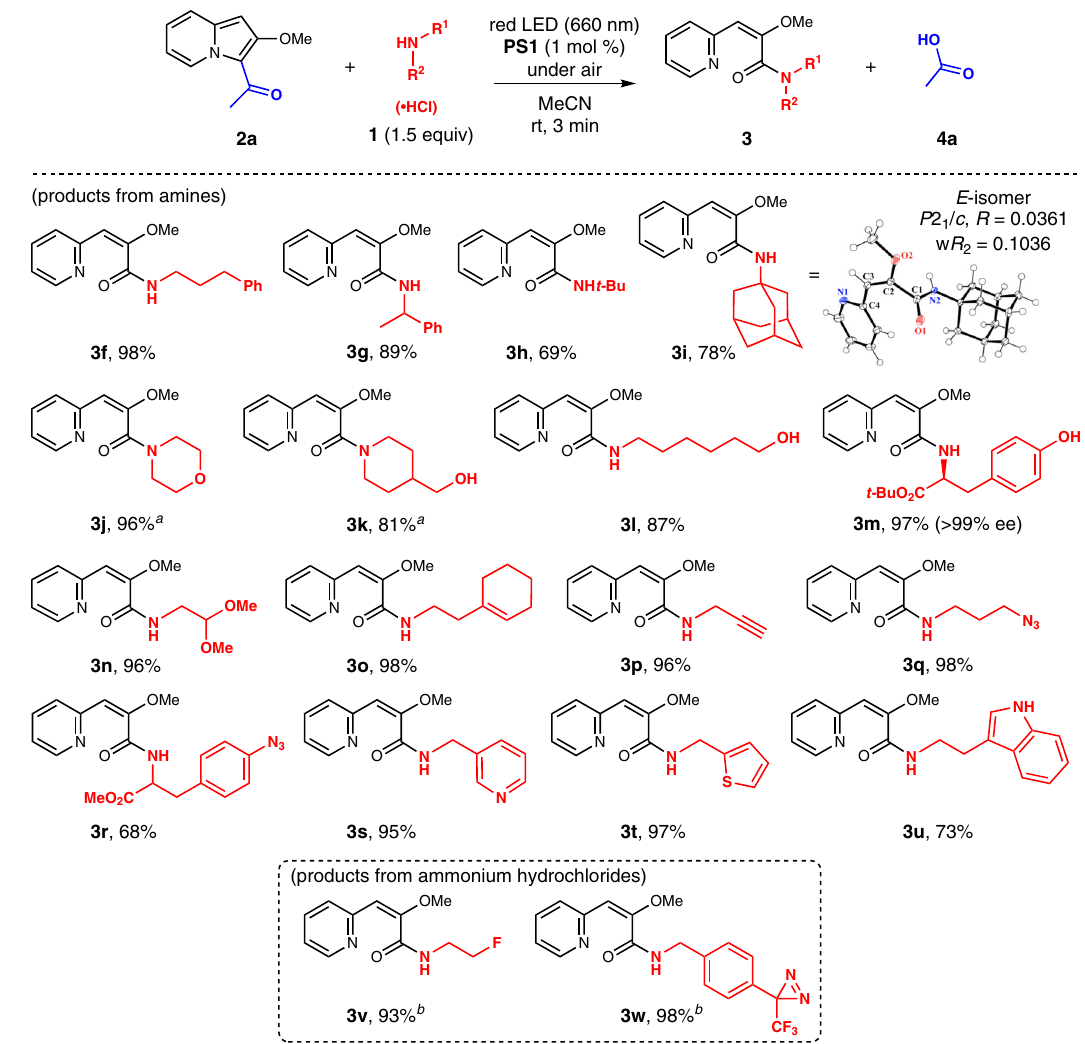
Fig. 3 Substrate scope of amines. Isolated yields are shown. a Irradiated for 4 min. b Na 2 CO 3 (1.5 equiv), MeCN/H 2 O